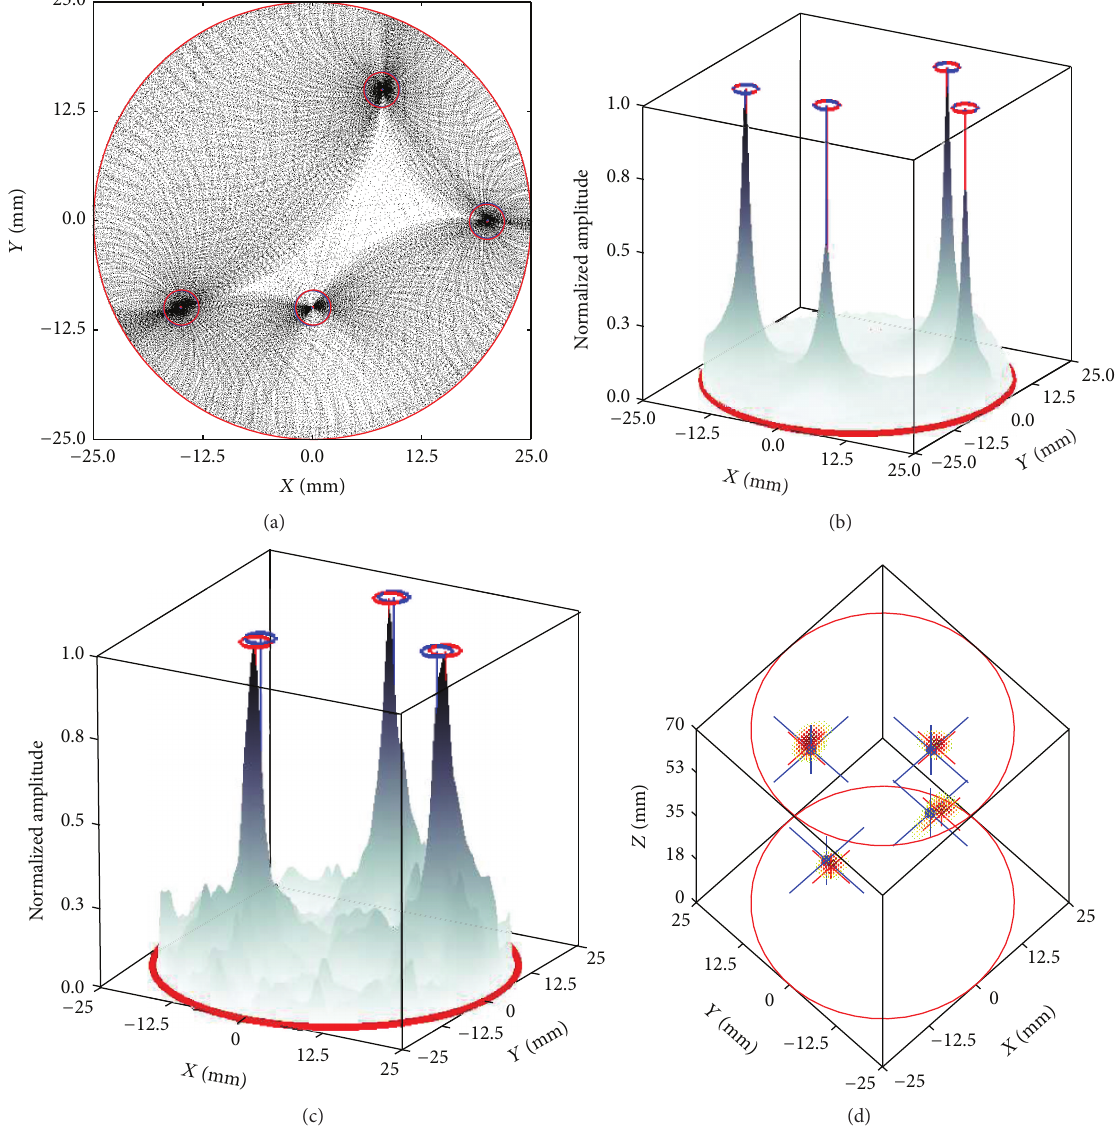
Figure 11: (a) Ovals density map for inclusions all located in a plane (planar 2D case). For all results presented here, red circles show the localized inclusions, whereas blue circles indicate their actual (true) positions. (b) Height function corresponding to (a). (c) Localization result with experimental data for 3 inclusions in a plane. (d) Localization result with experimental data for 4 inclusions in